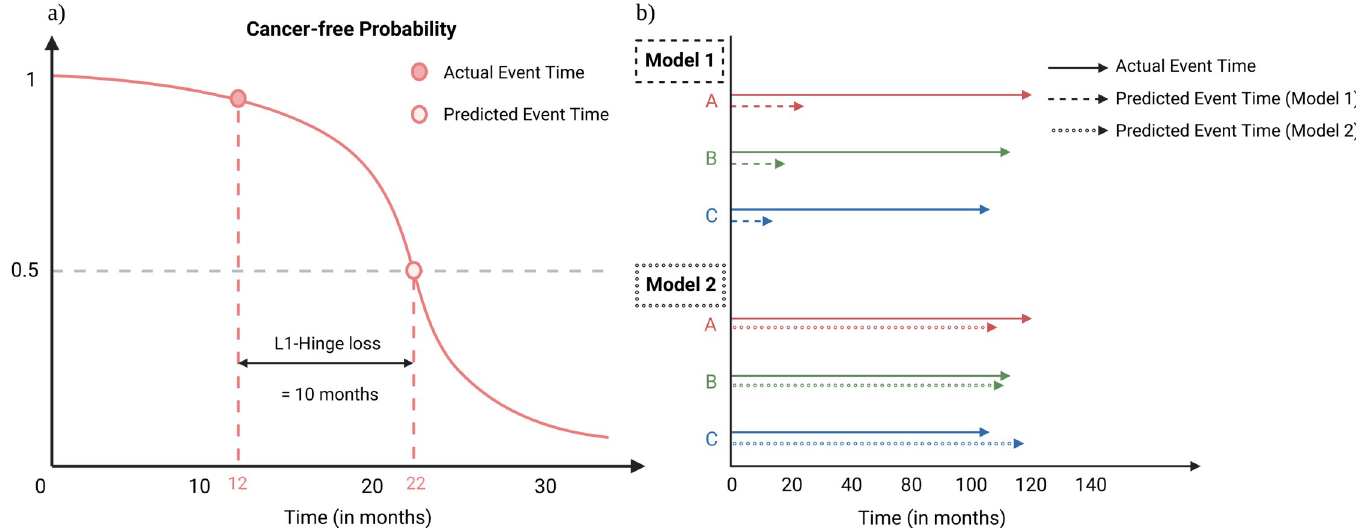
Fig 4. Illustration of the L1-Hinge loss and its comparison with the C-index. (a) L1-Hinge loss calculation from an ISD curve for an uncensored participant in ATP-BCa dataset. (b) Comparison of the L1-Hinge measurement and the C-index (see Section 5.3 for details). The dashed and dotted arrows indicate the expected BCaO times. (Note these examples are of uncensored